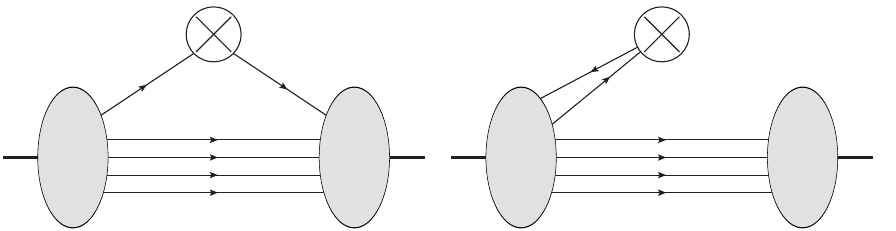
Figure 5. LFWFs decomposition of GPDs. Left panel, DGLAP region interpretation conserving parton number between incoming and outgoing states; right panel, ERBL region interpretation not conserving parton number as the incoming state emits a pair of